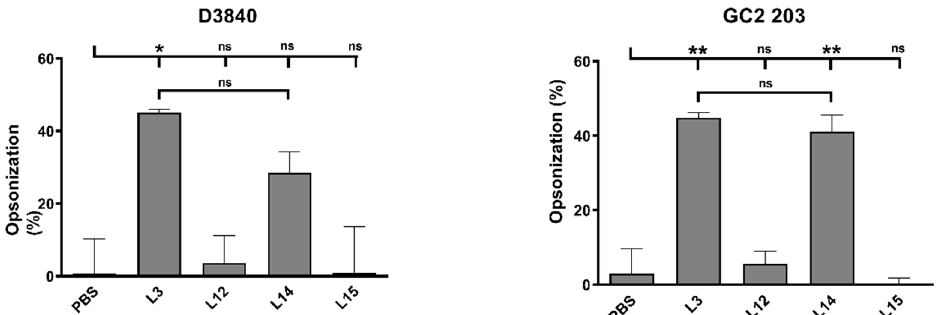
Figure 5. Average opsonization percentage of Group A Streptococcus strains (D3840 and GC2 203) by serum taken at day 52 after primary immunization in Swiss mice ( n = 5 per group). Statistical analysis was performed using one-way ANOVA followed by Tukey’s post hoc test to compare with PBS-administered mice (ns, p > 0.05; * p < 0.05; ** p < 0.01;). Statistical analyses were performed using GraphPad Prism version 8.03.